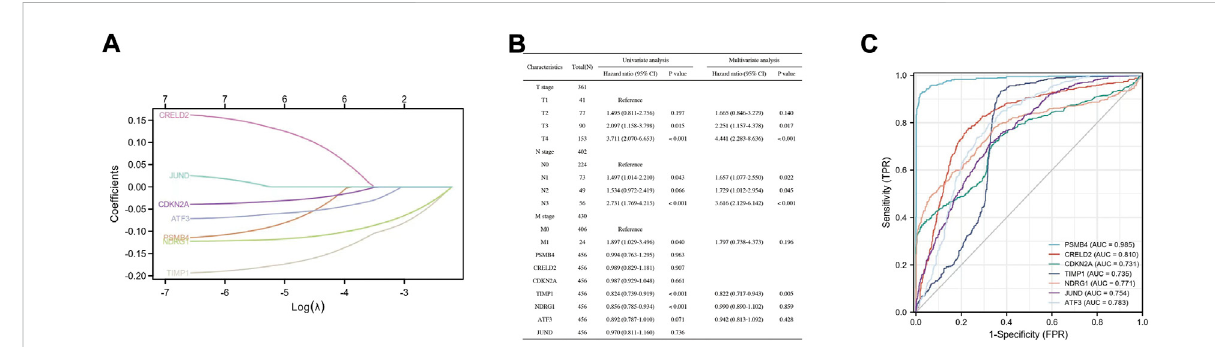
FIGURE 5 Construction of a diagnostic model to verify the DEGs effectiveness of SKCM prediction. (A) LASSO logistic regression algorithm to verify the DEGs. (B) Univariate and multivariate analysis of the DEGs using the Cox proportional hazard regression model. (C) The ROC curve of the diagnostic ef fi cacy veri fi